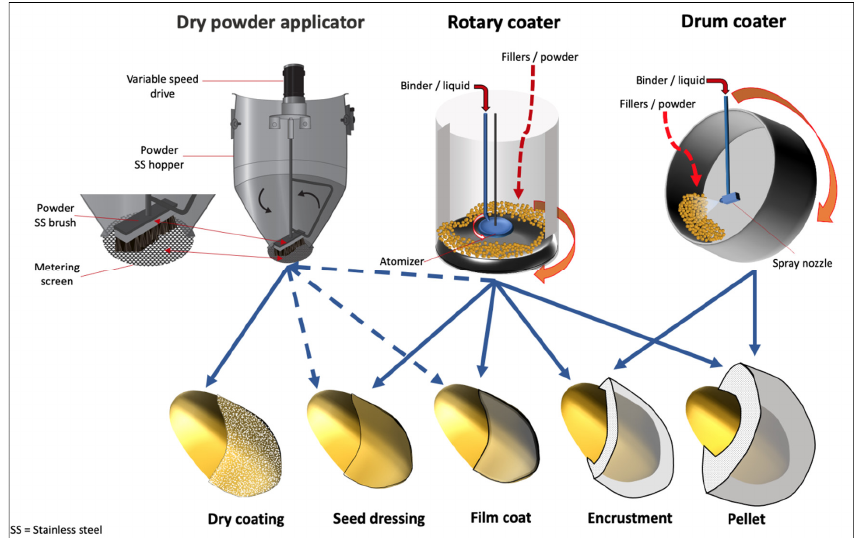
Figure 1. The three major types of seed coating equipment: dry powder applicator, rotary coater and drum coater used to produce five seed coatings: dry coating, seed dressing, film coat, entrustment and seed pellet.